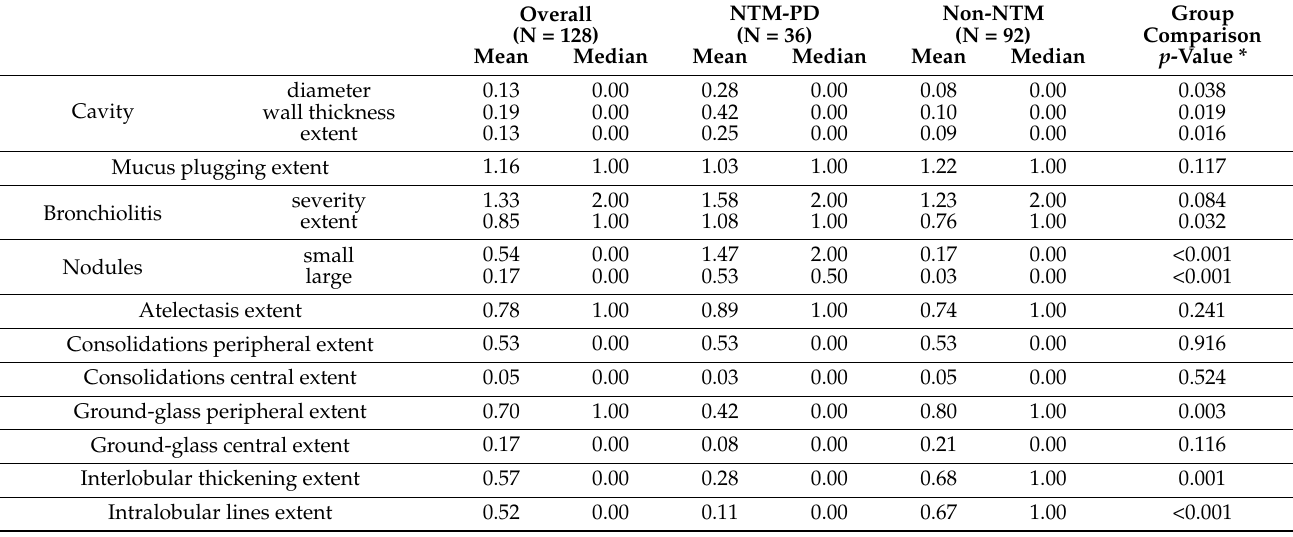
Table 4. Results of the collateral findings in CT.